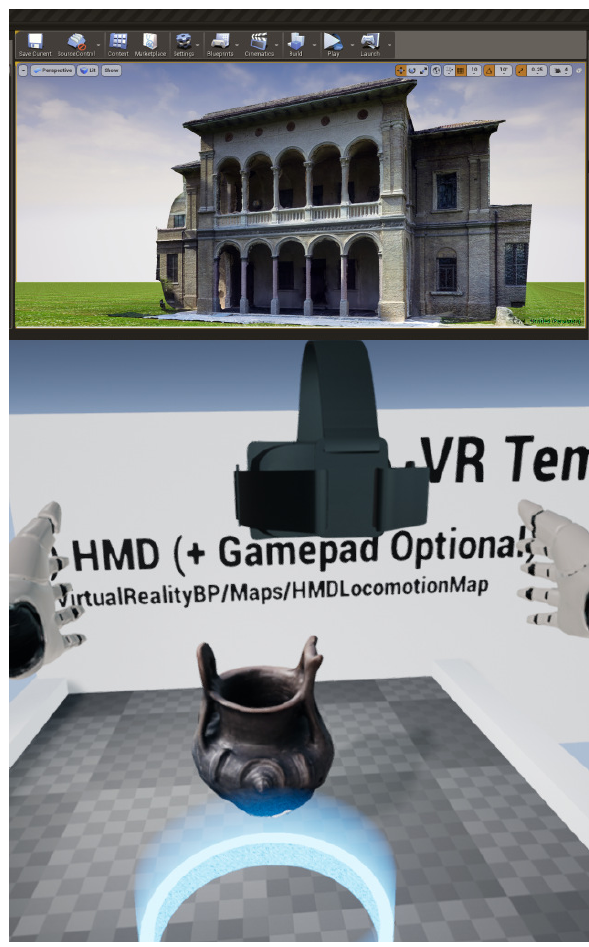
Figure 12. Comparison between the two virtual systems conducted on case studies using the Unreal Engine platform, immersive tour of Aurum building (top) and virtual manipulation on archaeological artefacts